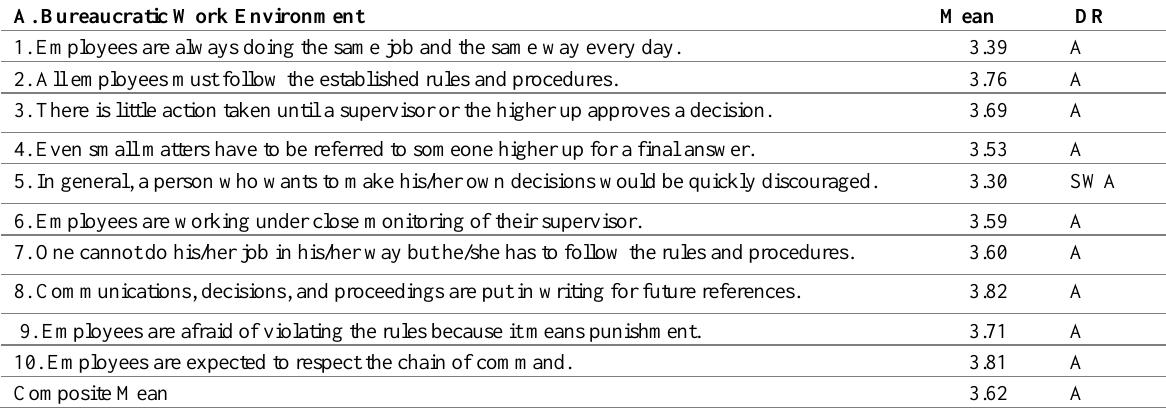
Table 6: Work Environment of the Divine Word Colleges in the Ilocos